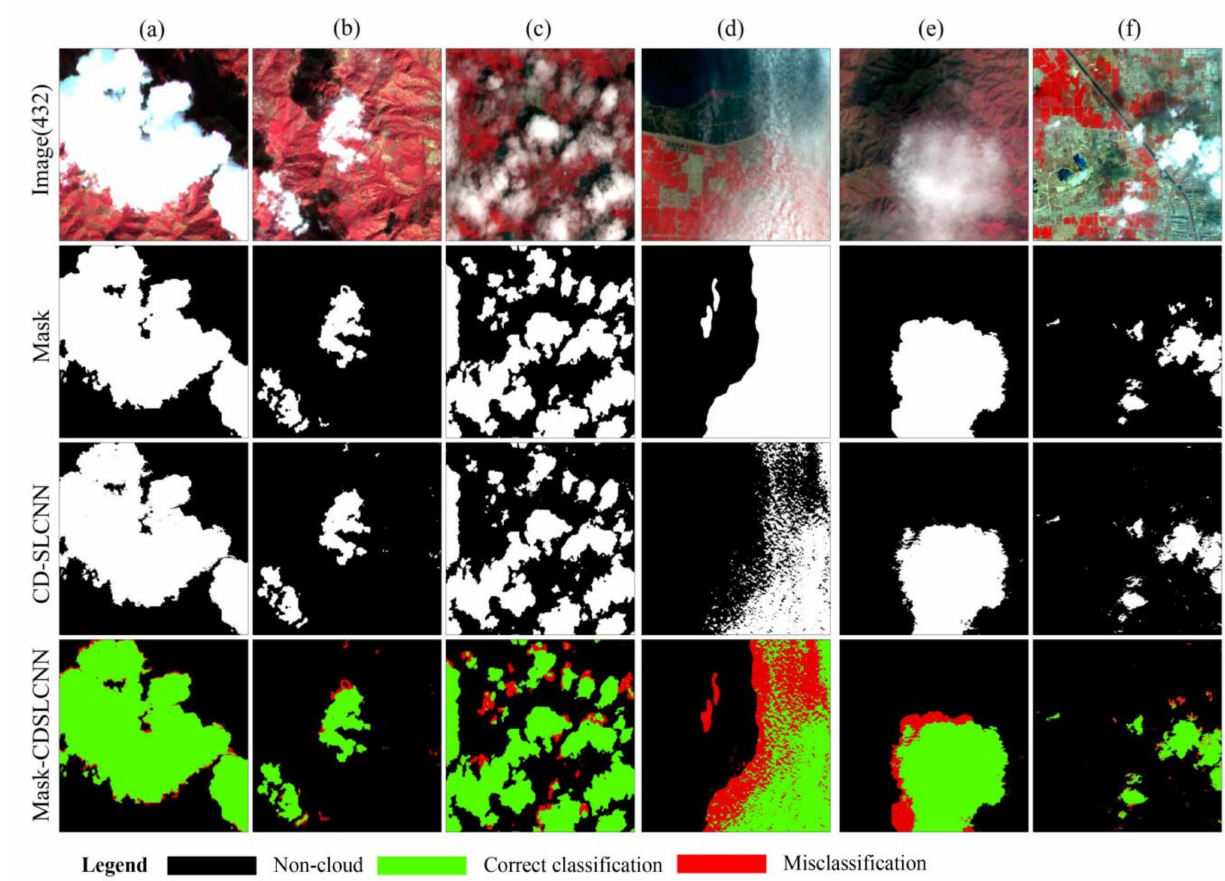
Figure 10. Qualitative comparison of cloud detection results in Sentinel-2A images over diverse underlying surfaces: ( a ) forest areas, acquired on 21 January 2020; ( b ) shrubland areas, acquired on 20 April 2019; ( c ) grass and island water areas, acquired on 27 July 2020; ( d ) urban and ocean areas, acquired on 23 March 2020; ( e ) bare soil areas, acquired on 23 March 2020; ( f ) urban areas, acquired on 30 March 2020.